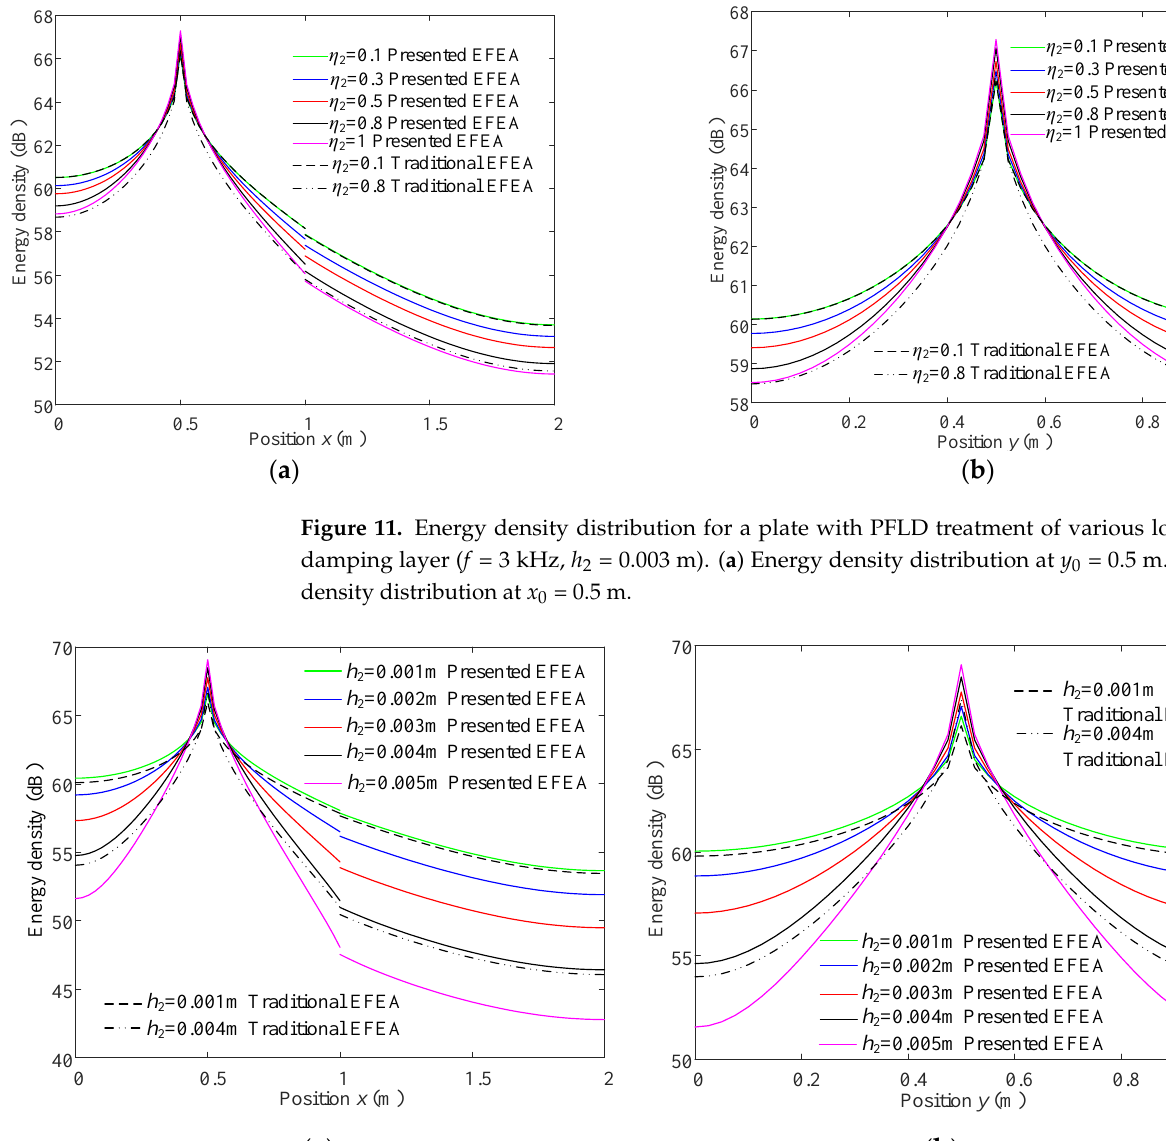
Figure 12. Energy density distribution for a plate with PFLD treatment of various thickness of damping layer ( f = 3 kHz, η 2 = 0.8). ( a ) Energy density distribution at y 0 = 0.5 m. ( b ) Energy density distribution at x 0 = 0.5 m.